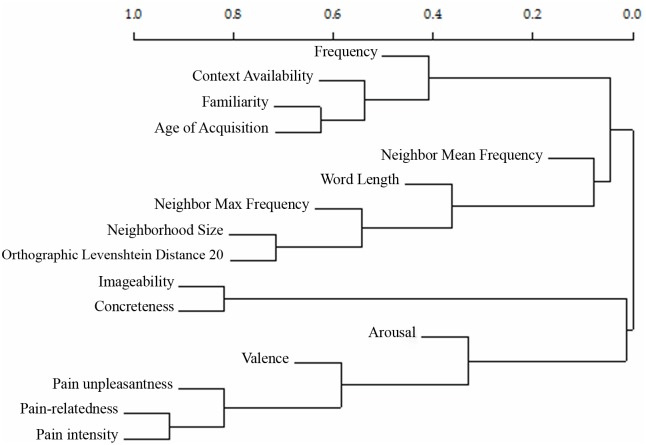
Hierarchical Clustering Analysis dendrogram.Dendrogram resulting from the Hierarchical Clustering Analysis of the 16 variables.